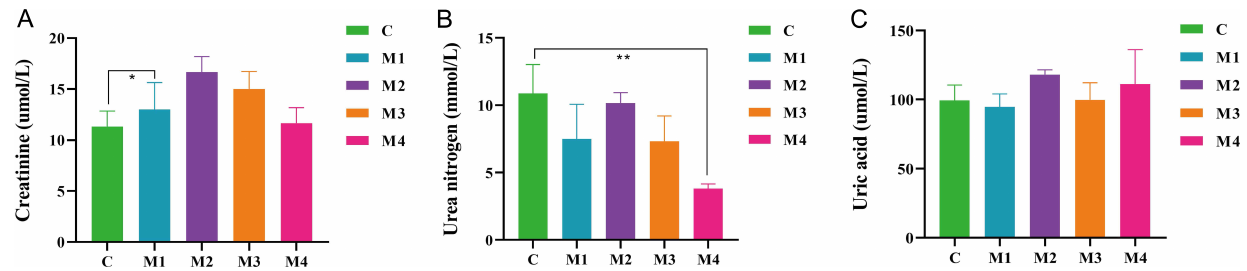
Figure 3. Effects of adenine combined with Folium sennae modeling on the blood biochemistry indexes of diarrhea mice. (A) Serum creatinine content. (B) Serum urea nitrogen content. (C) Serum uric acid content. Data were expressed as mean ± standard deviation, n = 6, * P < .05, ** P < .01.